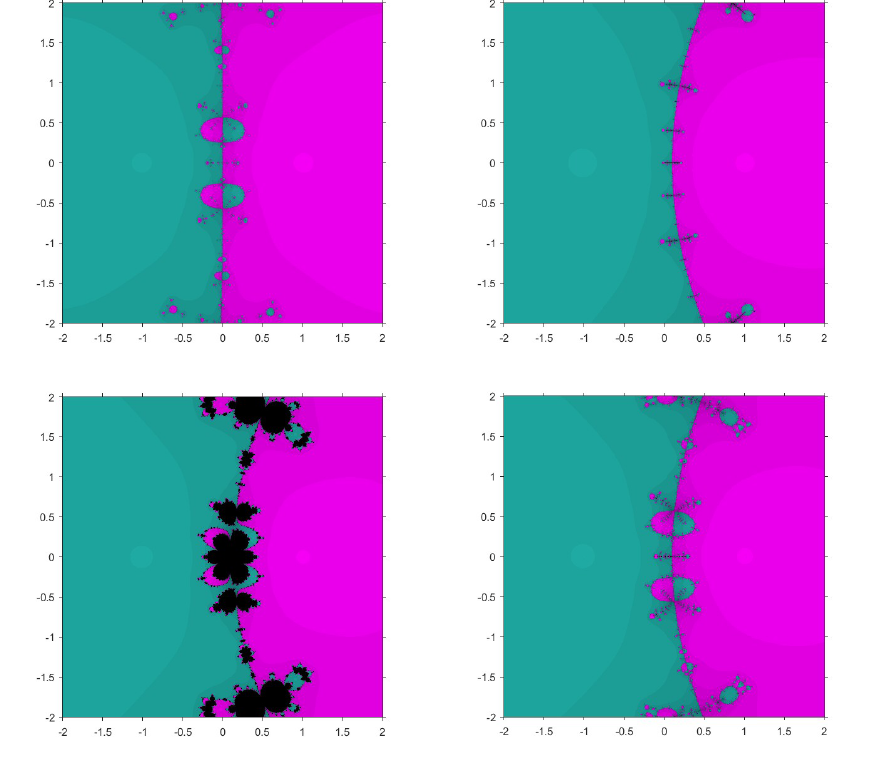
Figure 2. Basins of attraction for PMM , AM 2 , DM 1 , and DM 2 , respectively, for p 1 ( z )